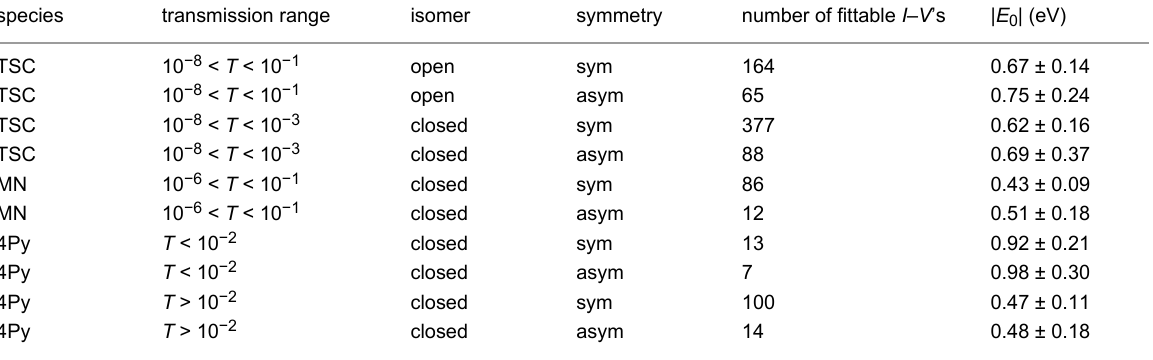
Table 1: Molecular energy level | E 0 | as plotted in Figure 4 and Figure 5 averaged over the indicated transmission ranges. Because of the systematic variation of | E 0 | with T for the species 4Py, we calculated separate average values for the low T < 10 − 2 and the high T > 10 − 2 range. The I – V ’s are categorized as symmetric when the ratio α = Γ R / Γ L is in the range of 0.5 ≤ α ≤ 2, and as asymmetric when the ratio is outside this range. The errors are the standard deviations of the averaging procedure.